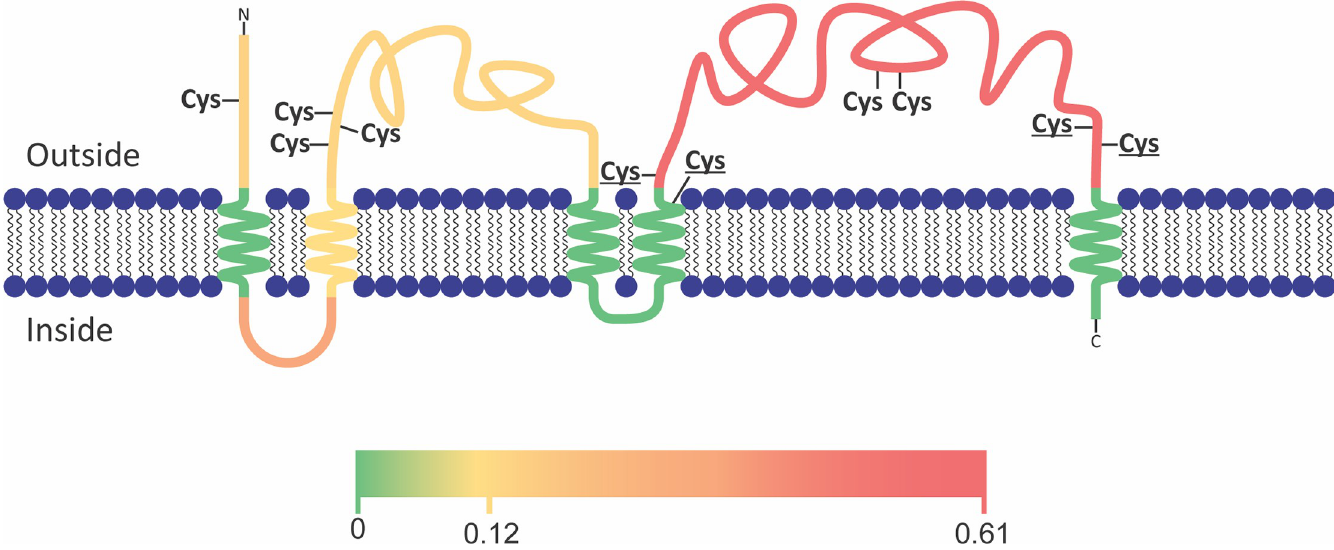
Fig 2. Predicted membrane topology of Pf3D7_0104100, a sporozoite-specific protein that is homologous to the prominin/CD133 protein family. The level of polymorphisms among P. falciparum strains is indicated for the separate regions using the color scale below the cartoon of the protein as the average number of polymorphisms per nucleotide in the strains in PlasmoDB. PF3D7_0104100 has a high density of polymorphisms within P. falciparum strains that are concentrated in the second extracellular loop. Cysteines that are conserved among the homologs in Plasmodium species are indicated. The cysteines that are conserved also in human homologs are in bold. Note that the conserved cysteines occur in close proximity to each other, suggesting the formation of disulphide bonds.